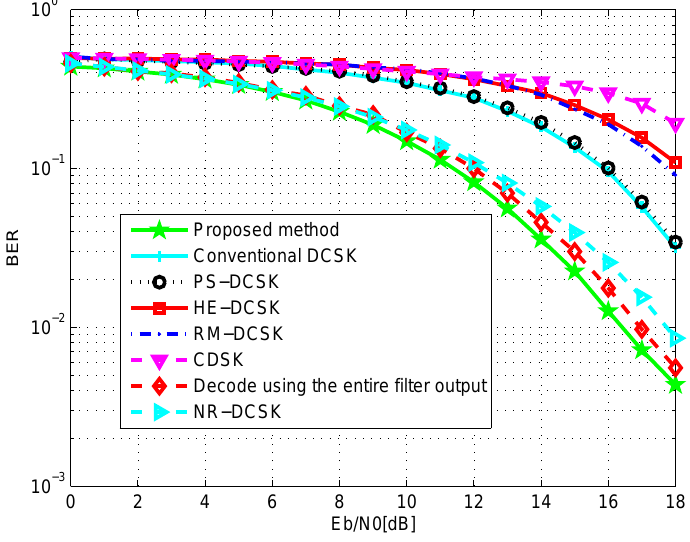
Figure 7. Performance comparison of conventional DCSK, NR-DCSK, HE-DCSK, RM-DCSK, PS-DCSK, CDSK and the proposed method over the underwater acoustic